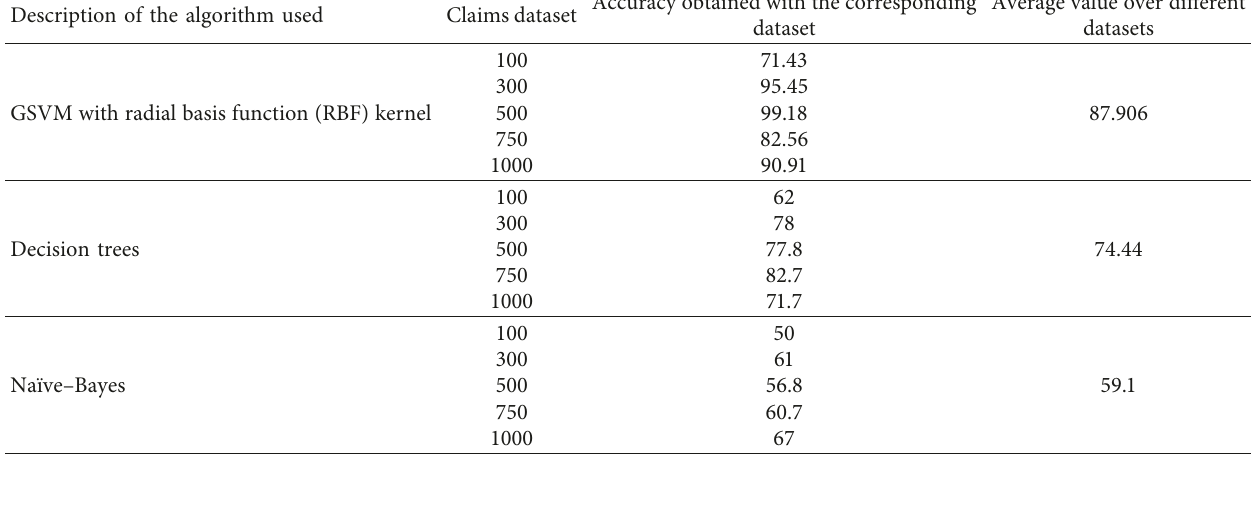
Table 7: Comparison of results of GSVM with decision trees and